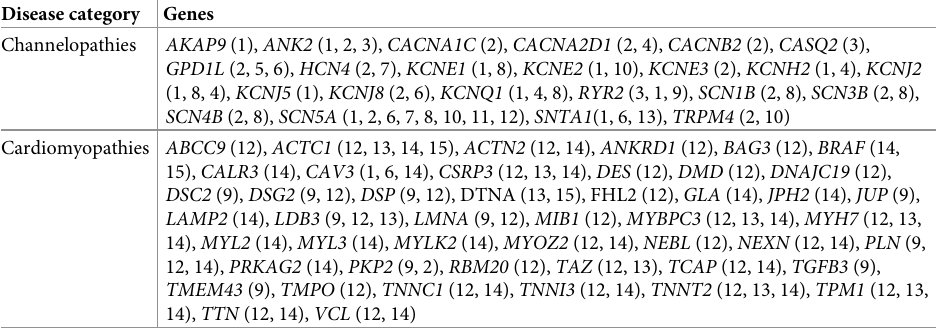
Table 1. Genes included in the customized HaloPlex gene panel and their associated diseases. Disease category